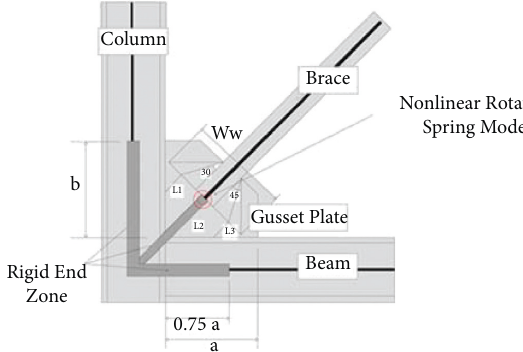
Figure 7: Brace connection model.